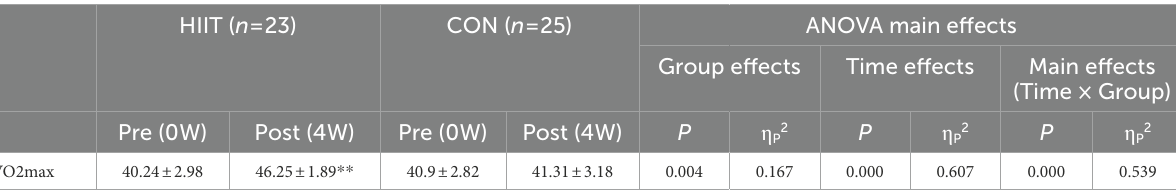
TABLE 4 Cardiovascular fitness of the two groups before and after the four-week program.